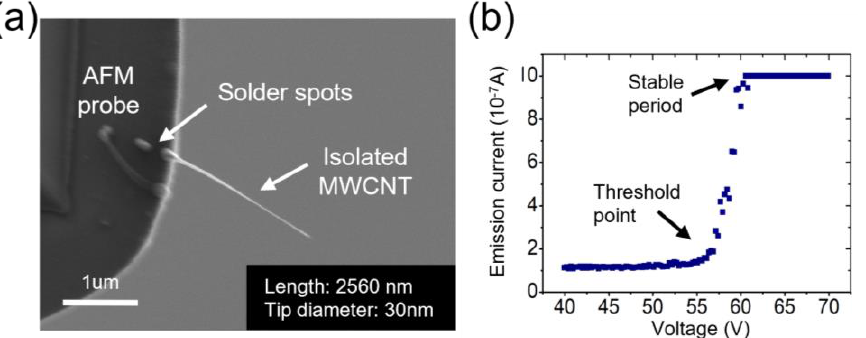
Figure 4. The initial status of the picked isolated MWCNT before the Pt shell growth, ( a ) an SEM image of the emitter; ( b ) the voltage versus current curve of the FE behavior of the isolated MWCNT.